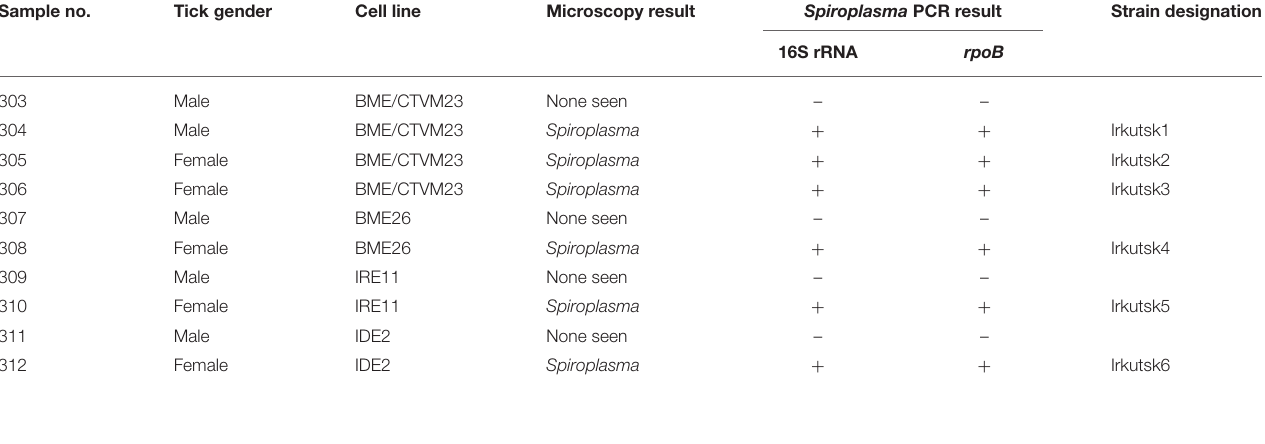
TABLE 1 | Detection of Spiroplasma by microscopy and PCR analysis of tick cell lines inoculated with internal organs from male and female Ixodes persulcatus ticks. Sample no.